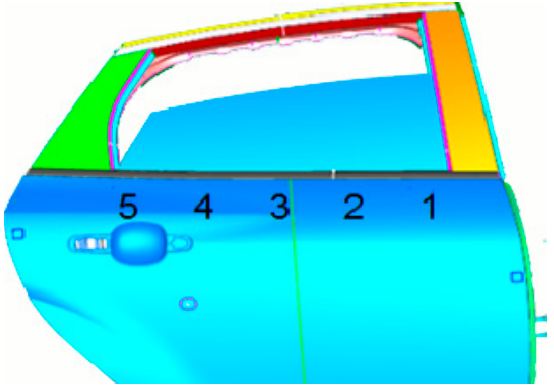
Figure 12. Location map of measuring points for door.